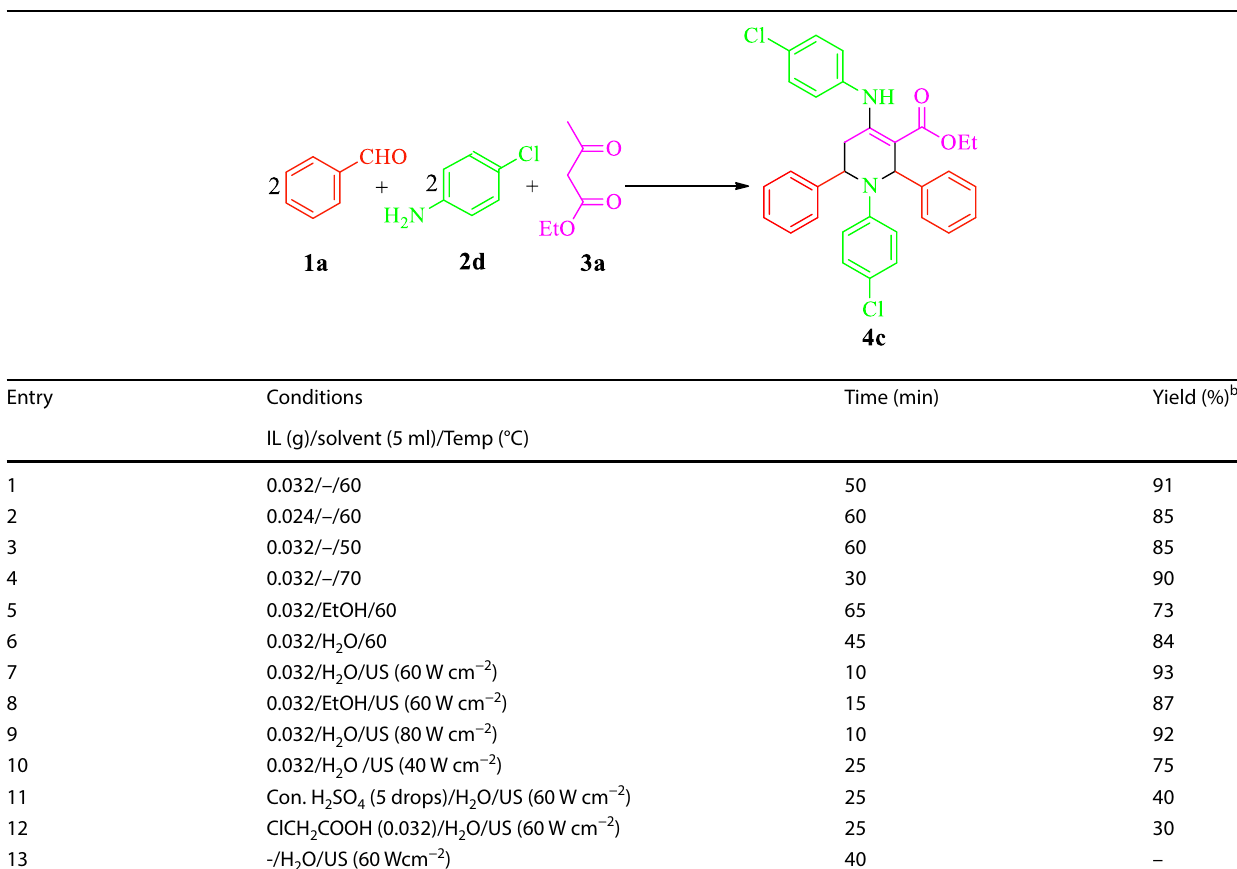
Table 1 Screening the reaction conditions in the synthesis of 4c